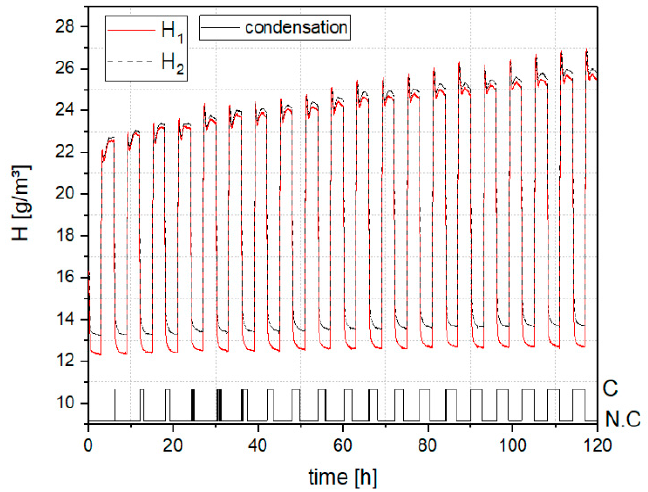
Figure 13. Absolute humidity of the air and condensation inside the housing during normal operation in case of the battery system equipped with PCE (test of 120 h).